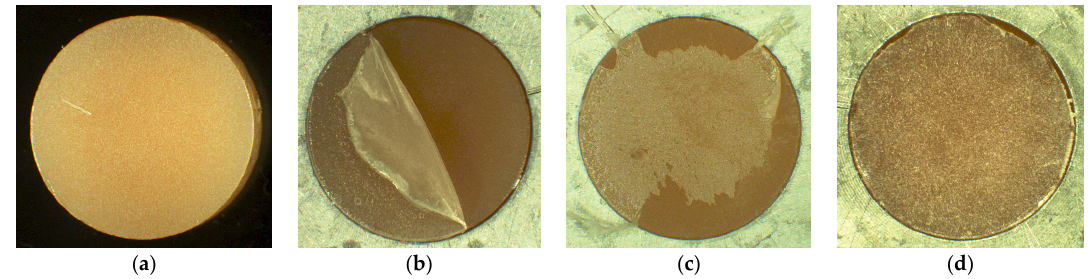
Figure 7. Valuation and scoring of adhesion strength between chitosan coating and PMMA surface: ( a ) PMMA specimen after chitosan coating; ( b ) no adhesion of chitosan coating; ( c ) low/fair adhesion after brushing; ( d ) good adhesion after brushing.